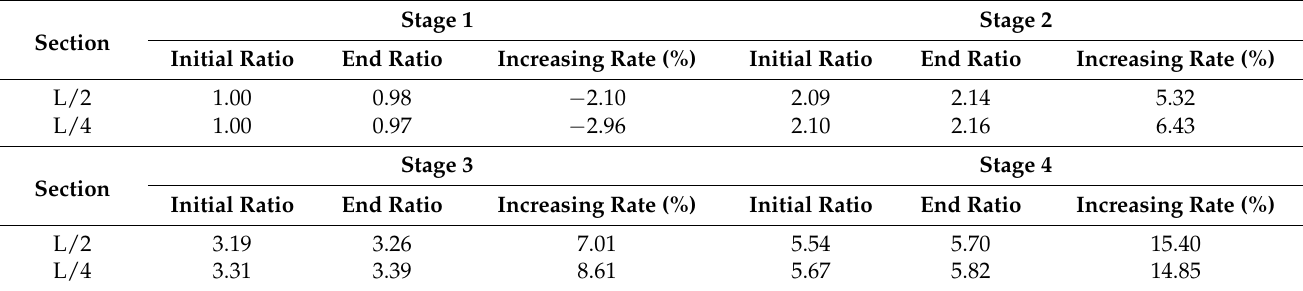
Table 2. The strain amplitude ratio ( ∆ ε N / ∆ ε 0 ).